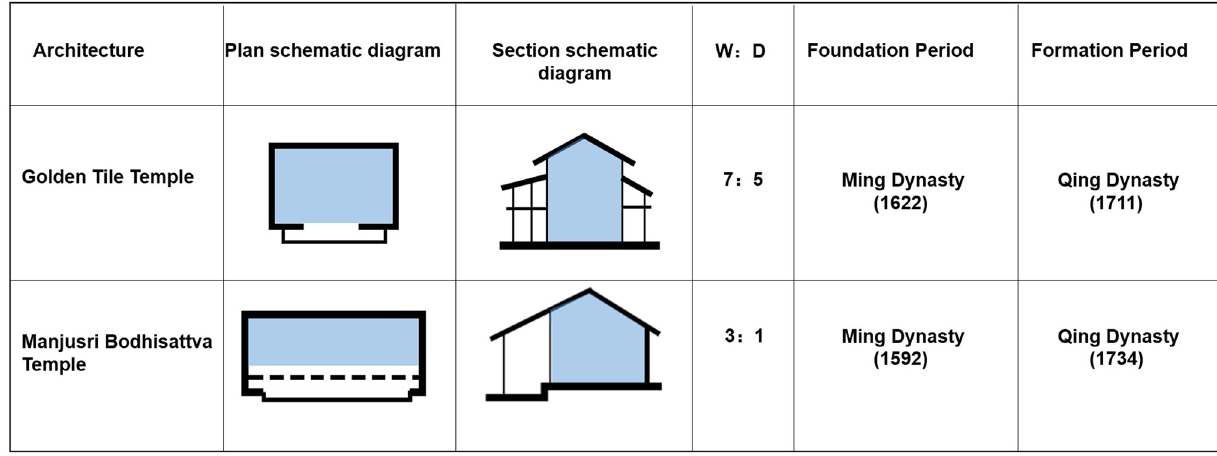
Fig 7. Spatial features of the palace buildings in type II. (W, width of the Palace Halls; D, depth of the Palace